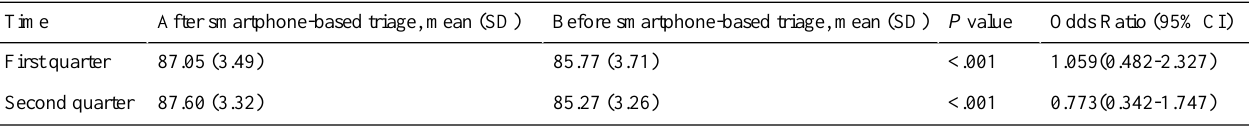
Table 3. Comparison of satisfaction level before and after smartphone-based